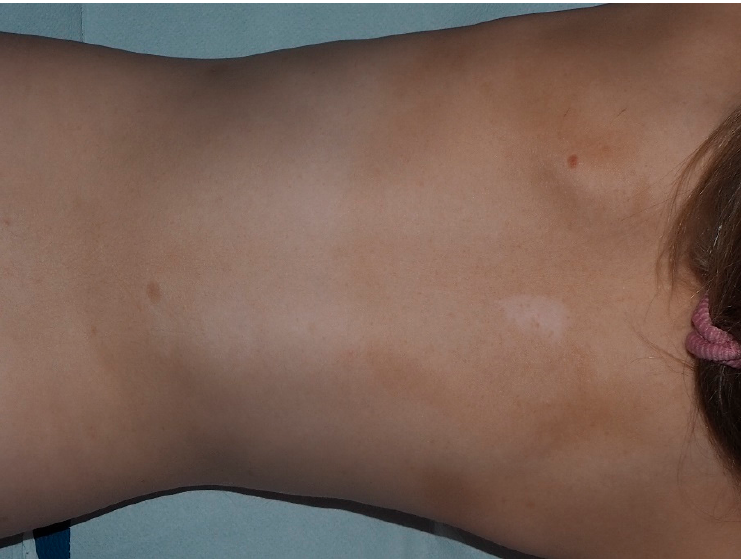
Figure 12. Nevus anemicus of the back in a female with NF1.